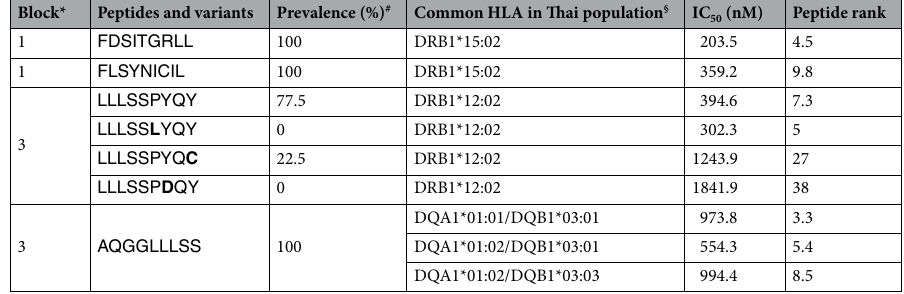
Table 9. Predicted HLA class II-binding peptides in PfGARP and distribution of variant alleles. *After Fig. 1. # Thai isolates. § Allele frequency > 10% 13 . Other common HLA class II alleles in Thai population